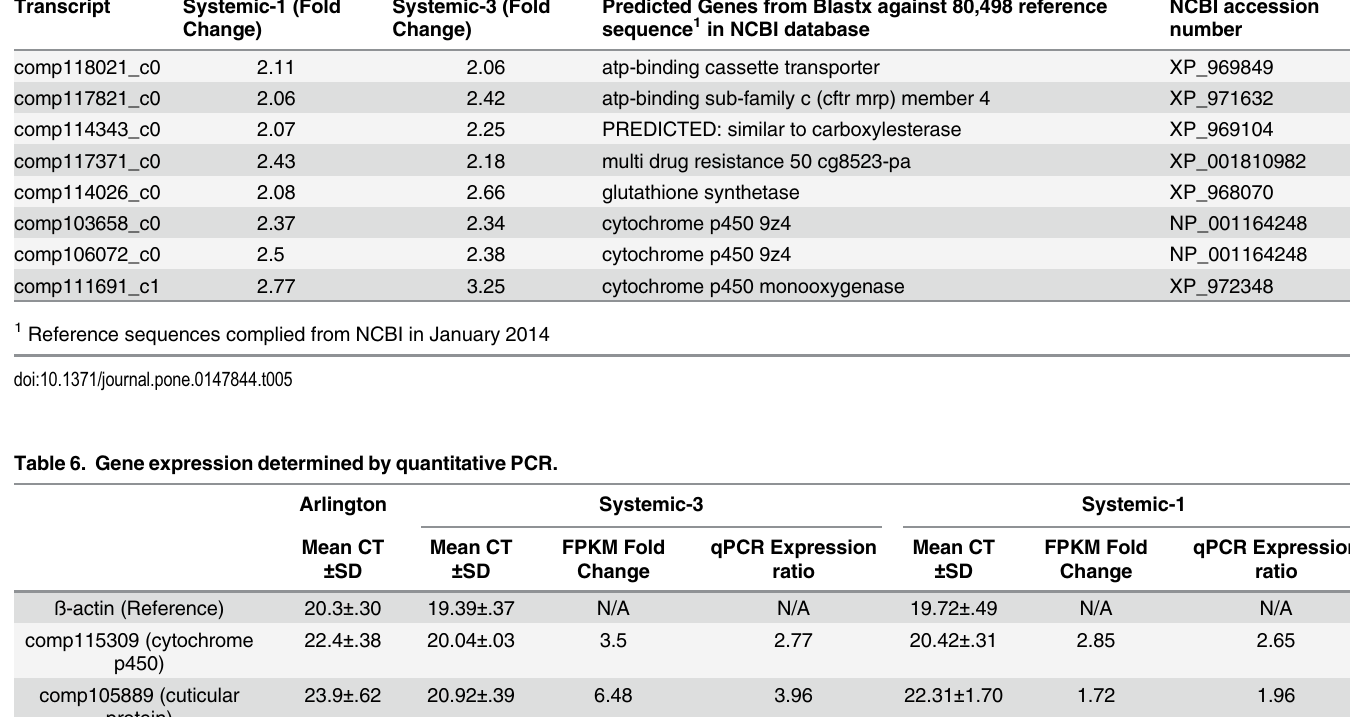
Table 5. Fold changes in the up-regulated genes observed between the two resistant populations, Systemic-1 and Systemic-3. Transcript